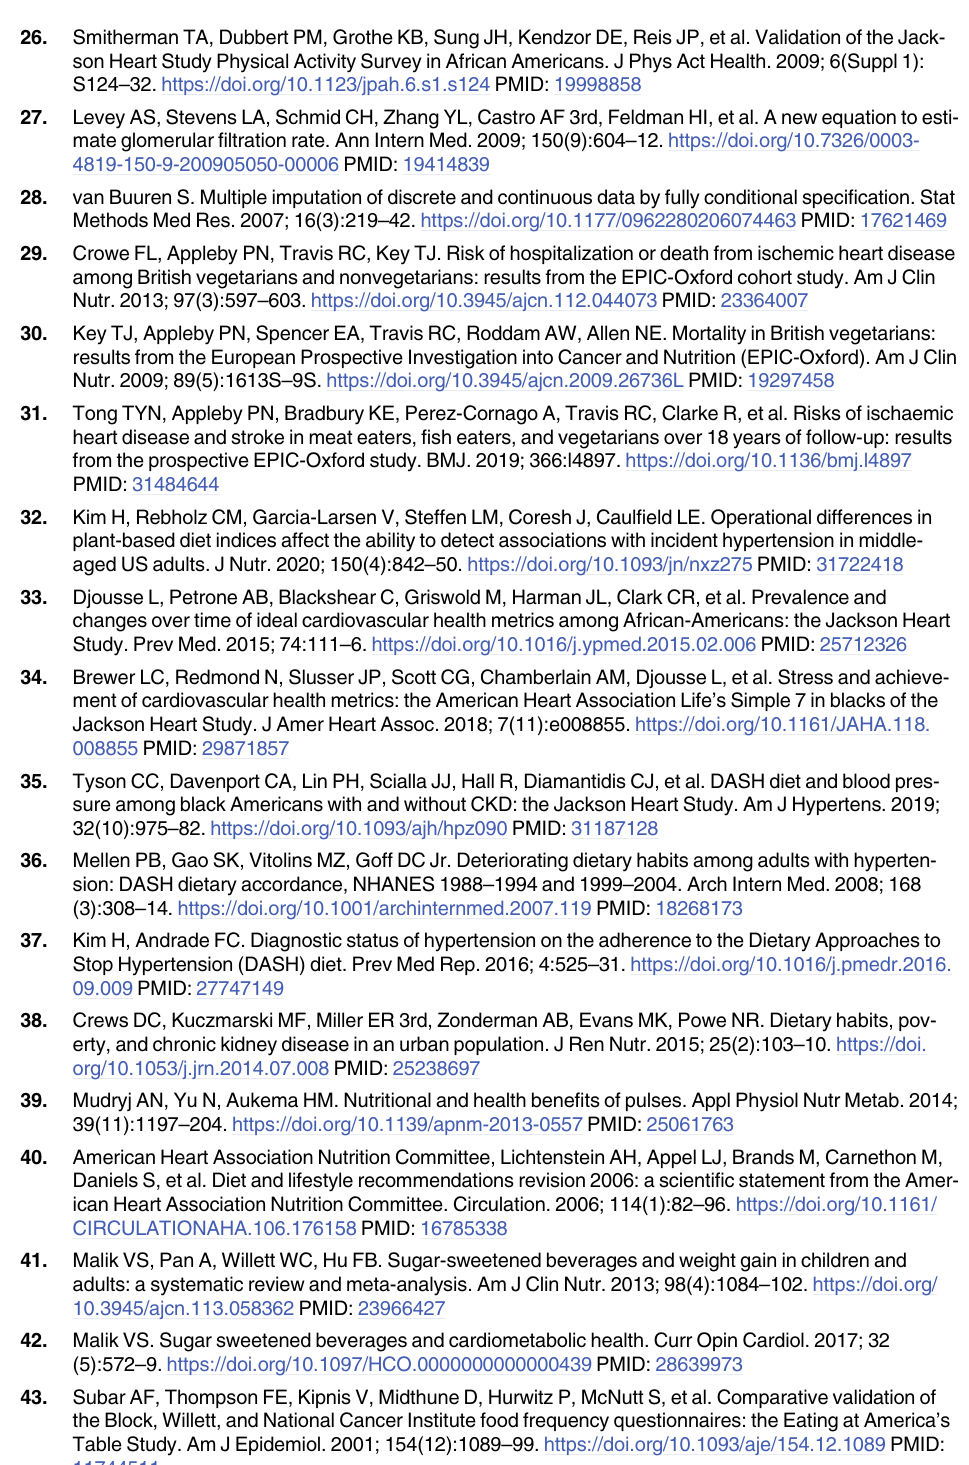
Table Study. Am J Epidemiol.2001; 154(12):1089–99.https://doi.org/10.1093/aje/154.12.1089 PMID: